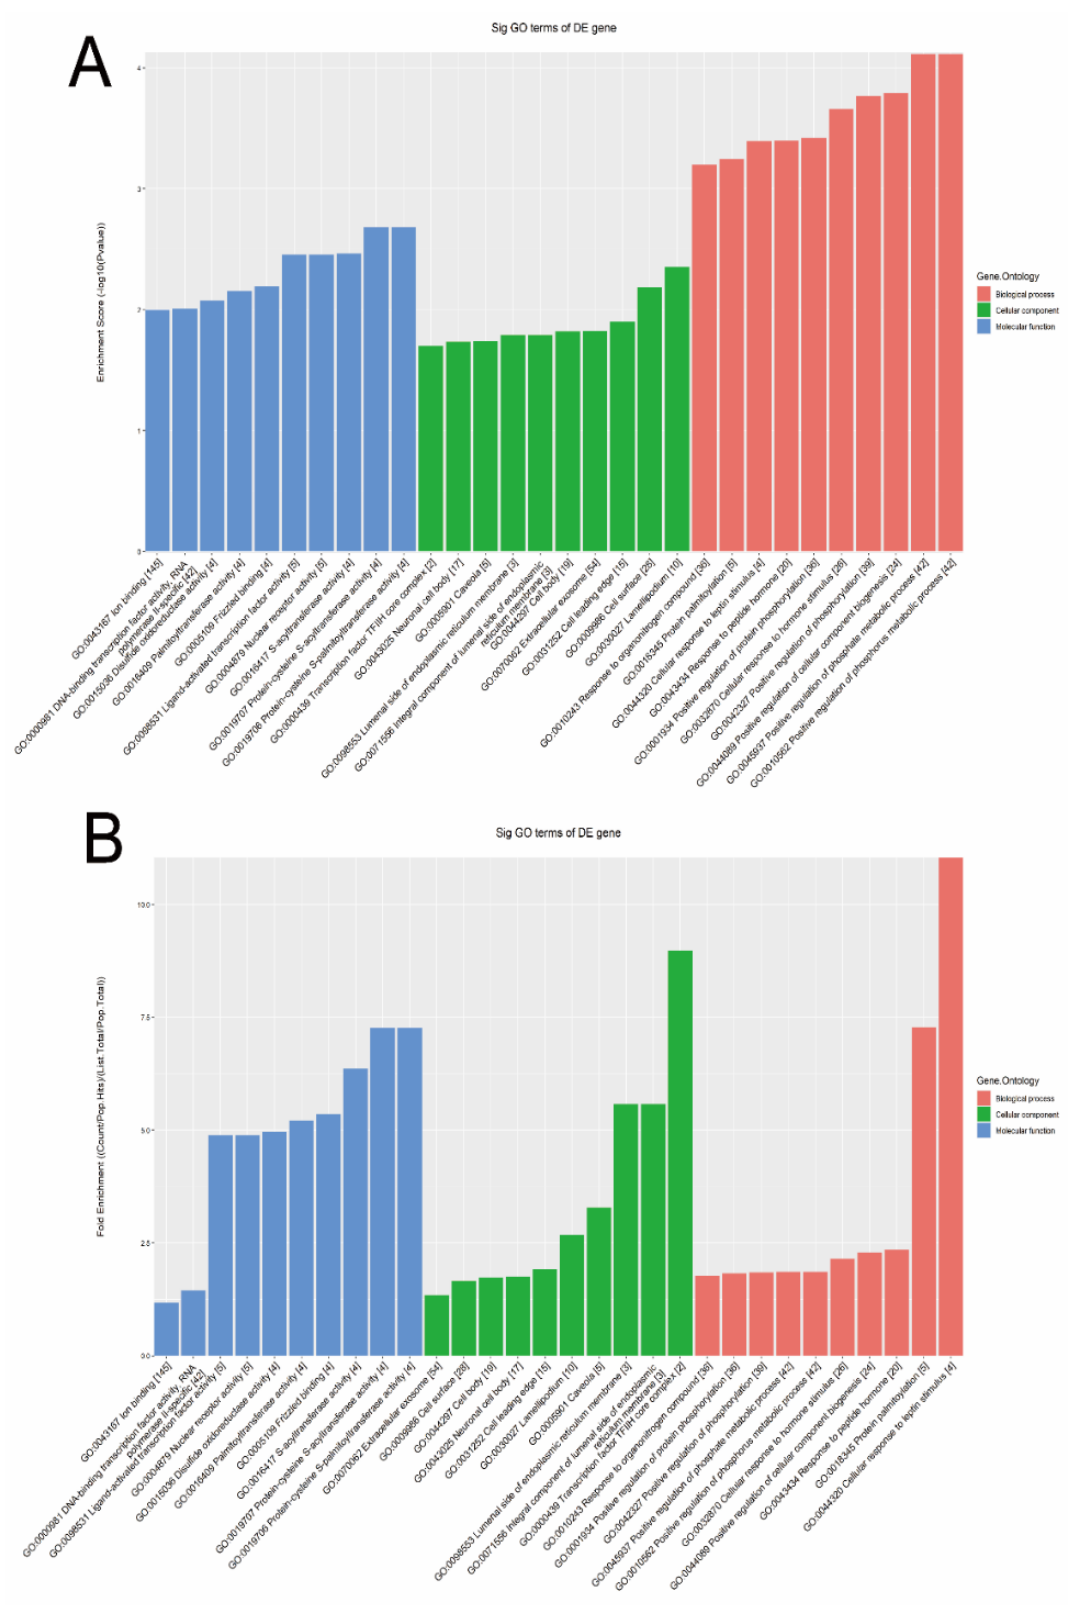
Figure 5. The general GO annotations enrichment score for cellular component, molecular function, and biological processes of the target mRNAs regulated by the four candidate tsRNAs. ( A ) Enrichment score. ( B ) Fold